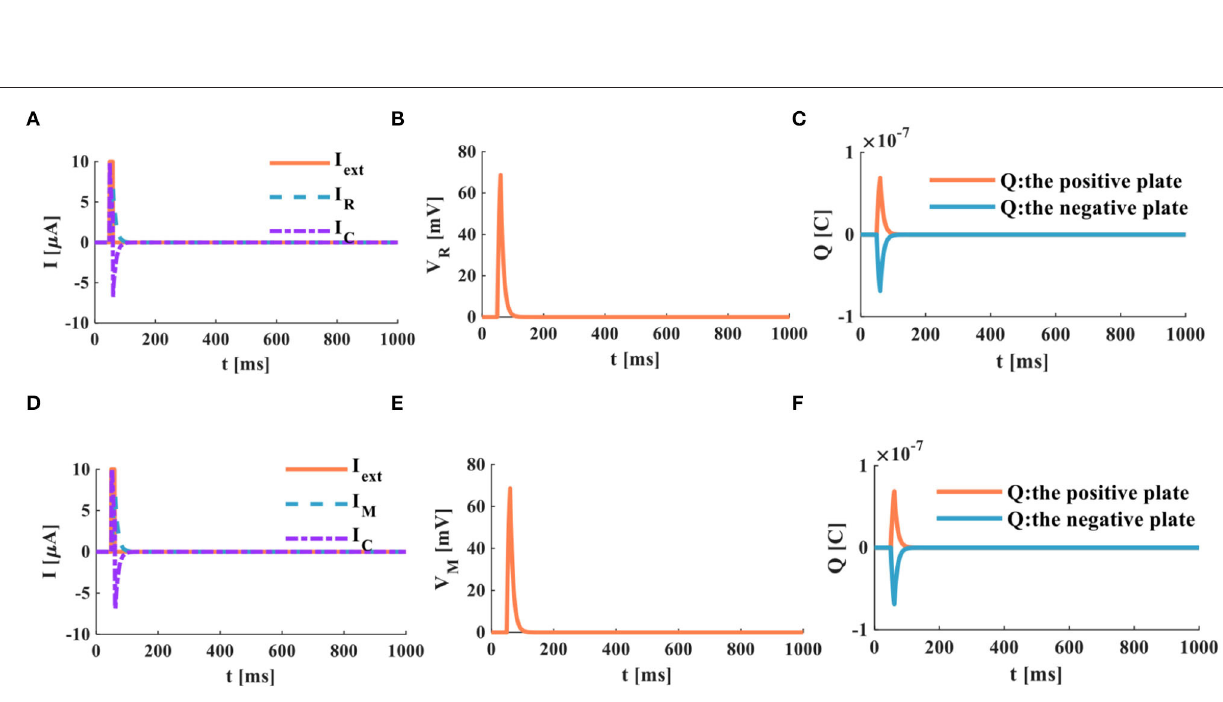
Frontiers in Neuroscience |